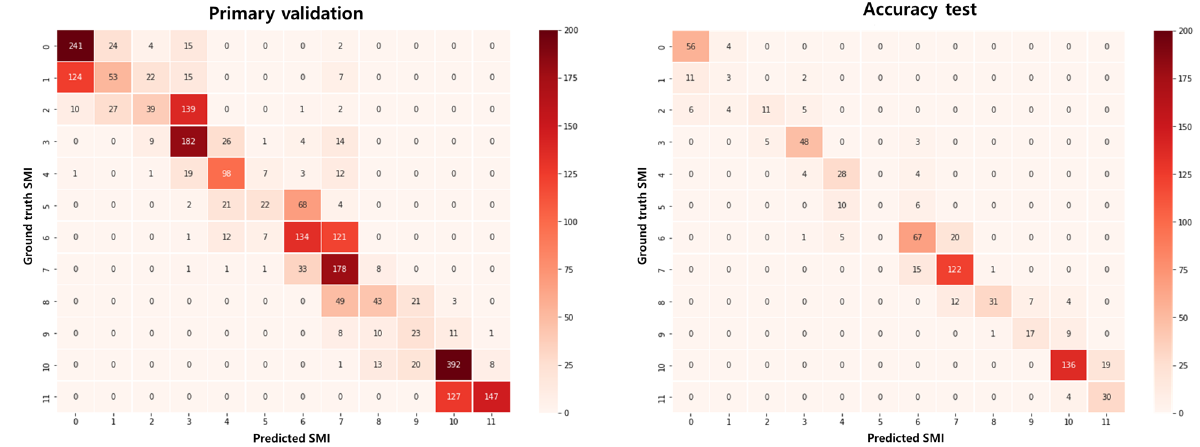
Figure 4. Confusion matrices showing the results of primary validation and accuracy test following fine